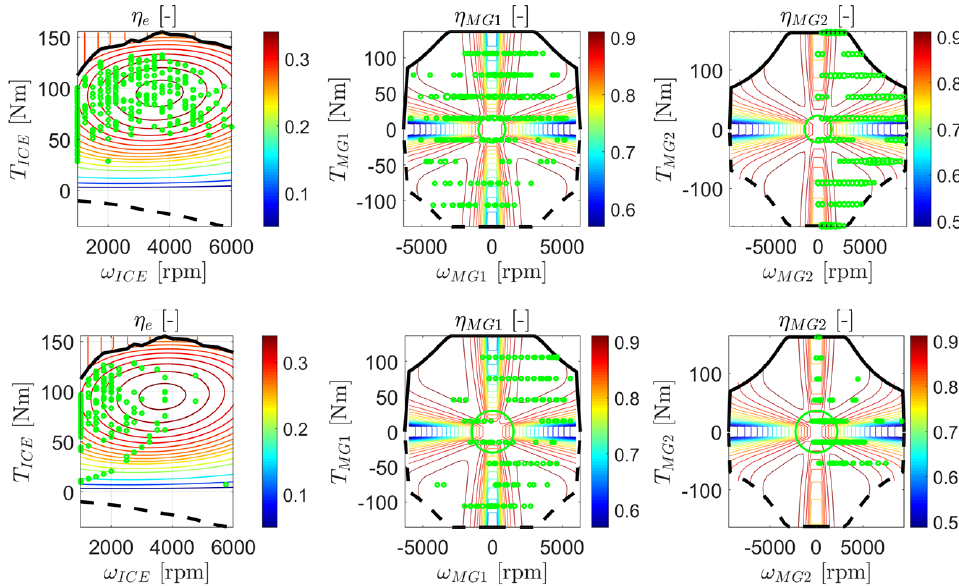
Figure 8. ICE ( left ), MG1 ( center ), and MG2 ( right ) operating points (green circles) for the Input Split ( top ) and Compound Split ( bottom ) modes and road slope α = 0. The procedure here proposed relies on the minimum energy consumption criterion, which leads to a charge depleting of the battery. Indeed, a large contribution of battery power, shown in Figure 9 together with ICE fuel consumption map, is requested during high speed acceleration.